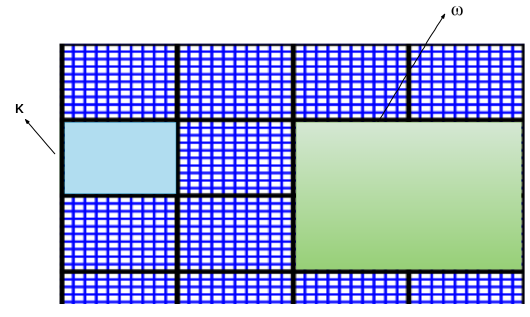
Figure 2. Domain Partition T H